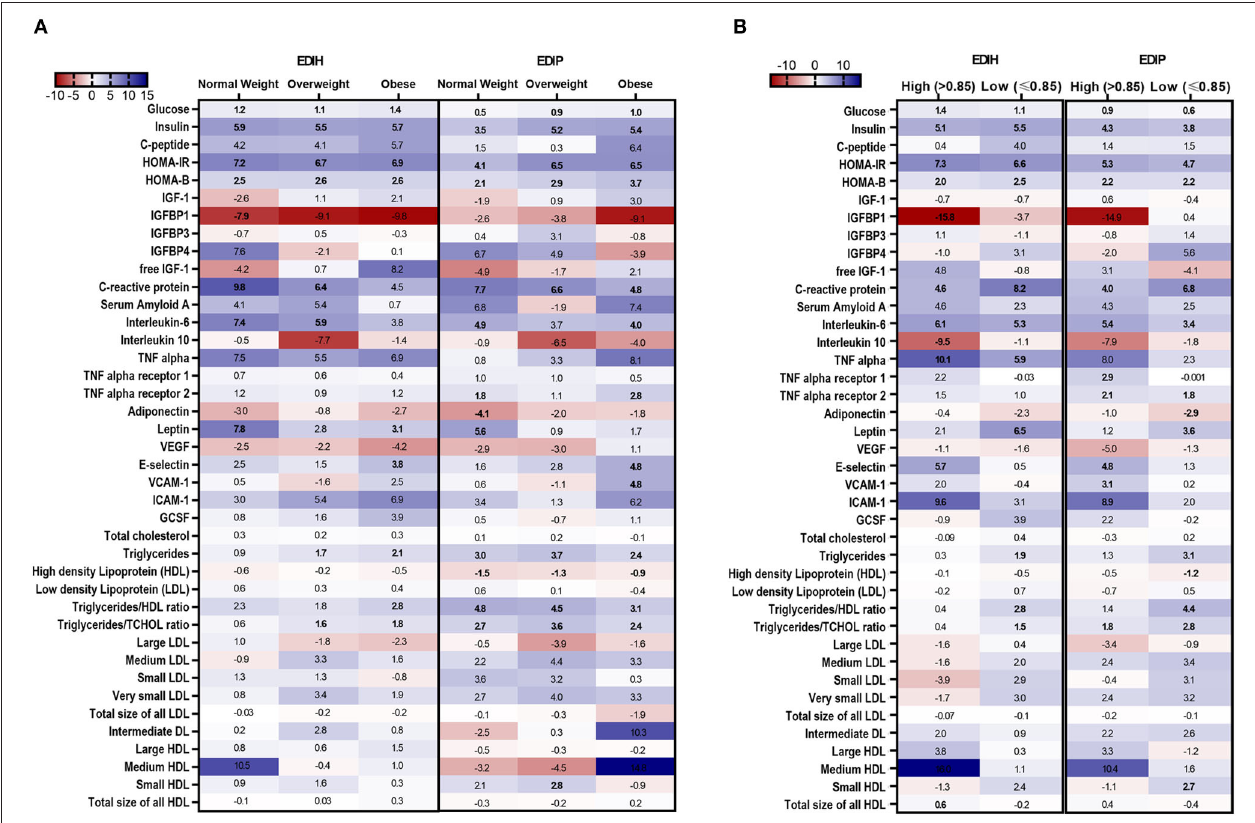
FIGURE 5 | Heat map showing the percentage difference (PD) in biomarker concentrations for each 1 standard deviation increment in the dietary index score in subgroups of BMI and waist-to-hip ratio (WHR). (A) BMI subgroups: normal weight, 18.5–24.9; overweight, 25–29.9; obesity BMI, 30–50 kg/m 2 . (B) WHR subgroups: high WHR > 0.85; low WHR ≤ 0.85. Biomarker concentrations were log transformed using natural logs. Values (beta coefficients) presented were obtained via multivariable-adjusted linear regression models adjusted for the following variables: total energy intake, BMI-continuous, age, total recreational physical activity, pack years of smoking; number of supplements used; fasting status at blood draw, race/ethnic groups, educational levels, regular use of NSAID, statins, unopposed estrogen and/or estrogen plus progesterone hormones, hormone therapy (HT) study arms. The color gradient ranges from red (inverse associations) to blue